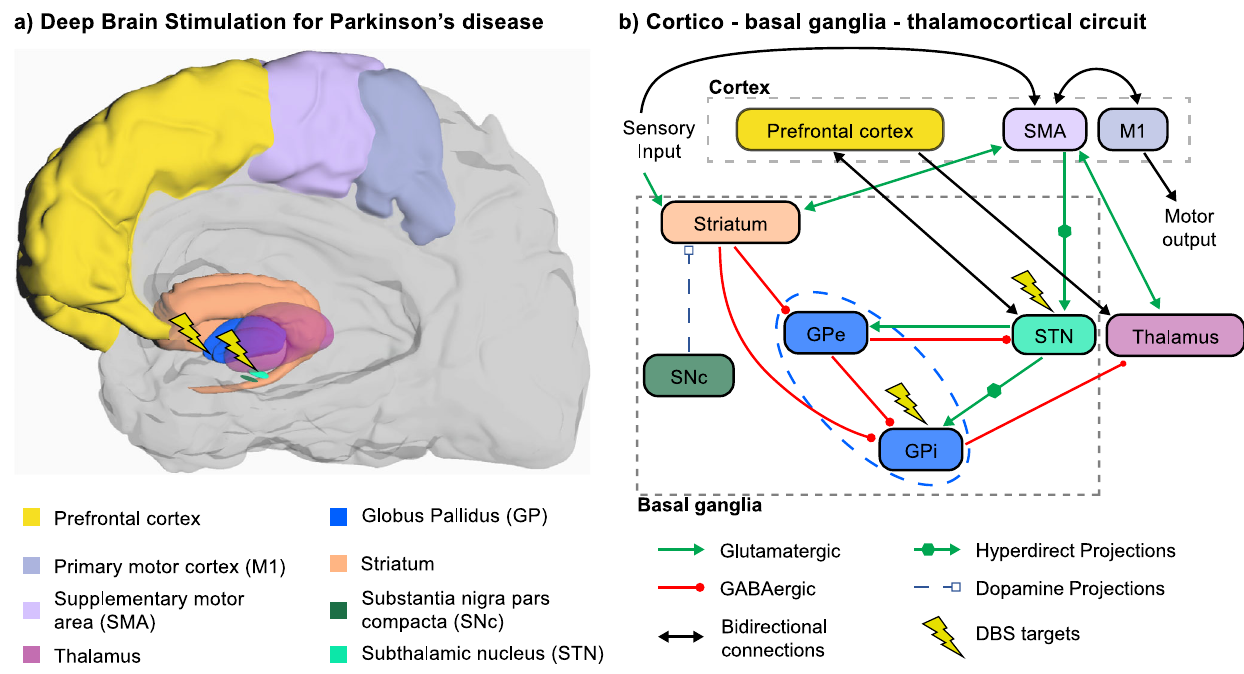
Fig. 2 Neuromodulation targets for motor symptoms in PD. a Anatomical locations of the BG, cortical and thalamic areas involved in the pathophysiology of PD. DBS targeting either the STN or the GPi (lightning bolts) is one of the main treatments for motor symptoms of PD. b The loss of dopaminergic cells within the SNc in PD induces dysfunction of the direct and hyperdirect pathways of the cortico-BG-thalamocortical circuit, which affects both motor and cognitive functions, and can be partially restored using DBS of the STN or